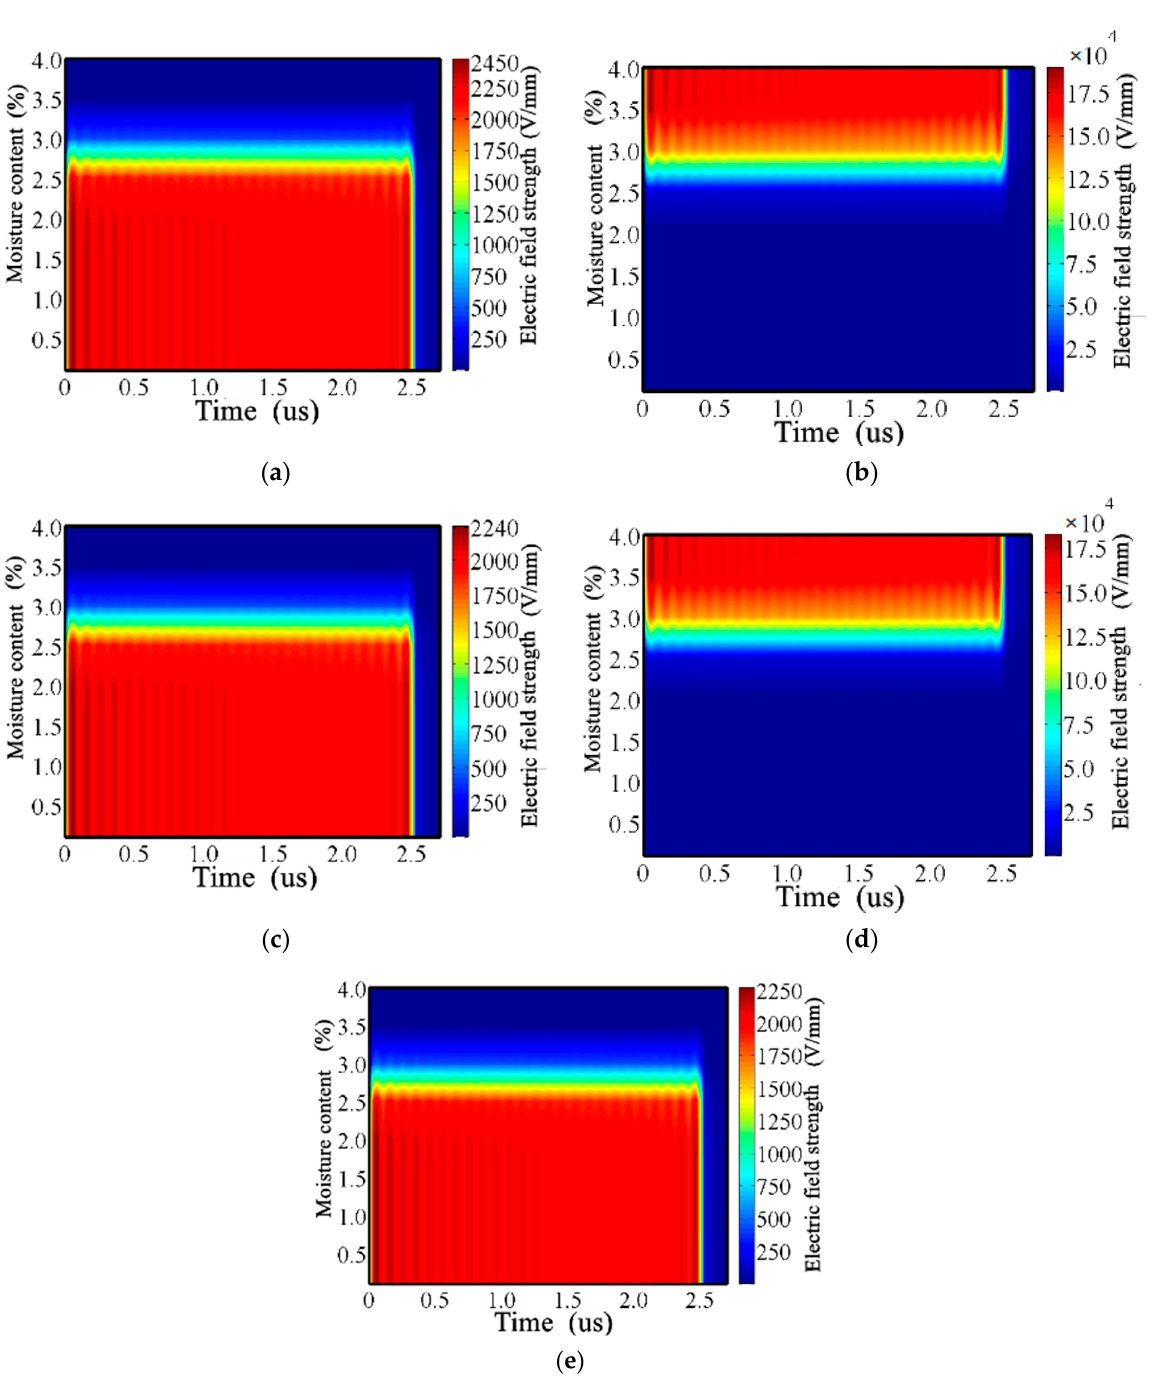
Figure 6. Changes of electric field intensity, at the end of each layer of the insulation system, with time under different humidity conditions: ( a ) oil-impregnated insulating paper I; ( b ) semi-conductive paper I; ( c ) oil-impregnated insulating paper II; ( d ) semi-conductive paper II; ( e ) oil-impregnated insulating paper III.